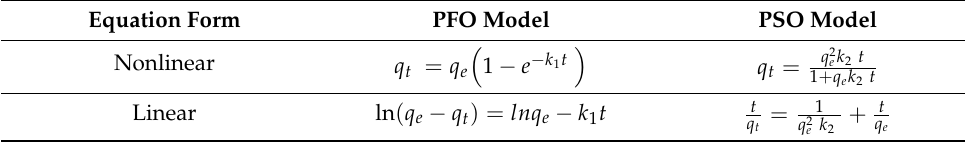
Figure 11. The dependence of the percentage of DO removal on the contact time with the plasma- treated LDPE power. Table 5. Nonlinear and linear forms of the PFO and pseudo-second-order (PSO) kinetic